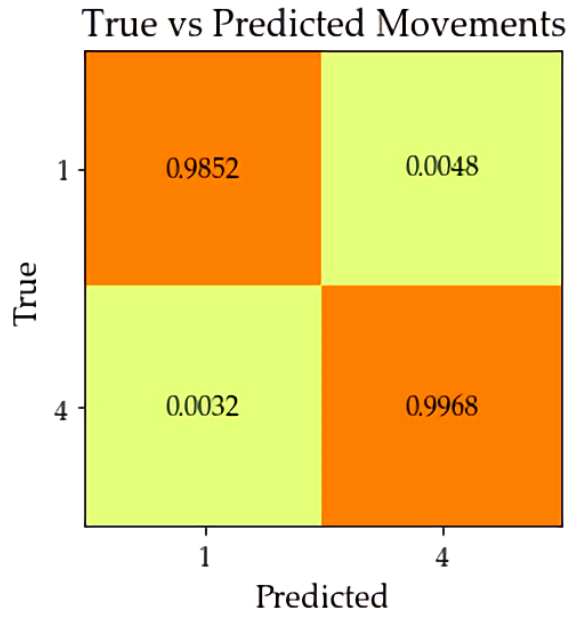
Figure 7. Results of generated/real samples on trained